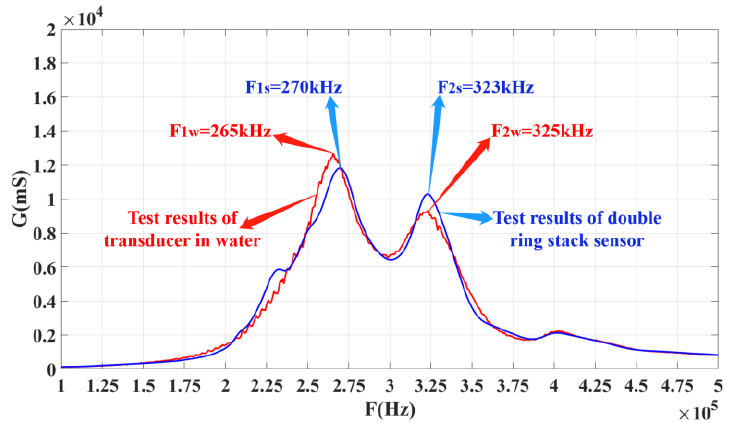
Figure 14. Conductance curve of the transducer in air and water.